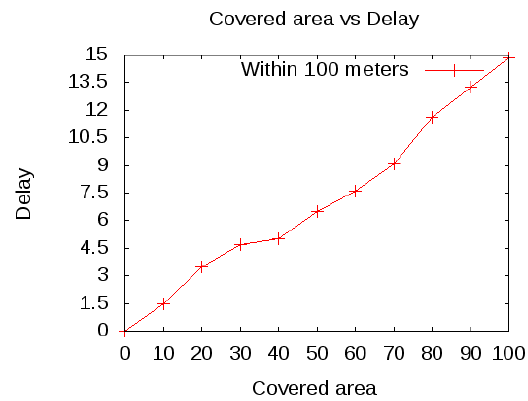
Figure 5. Delay due to presence of spoofing attack.